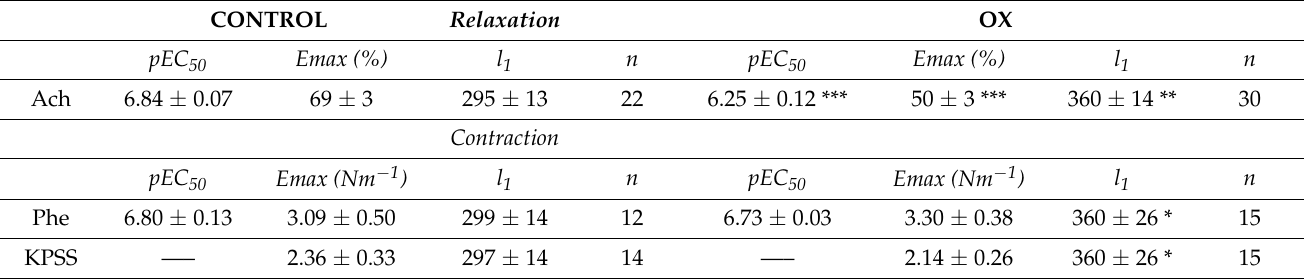
Table 1. Vasorelaxant and contractile responses of renal arteries from control and hyperoxaluric rats.